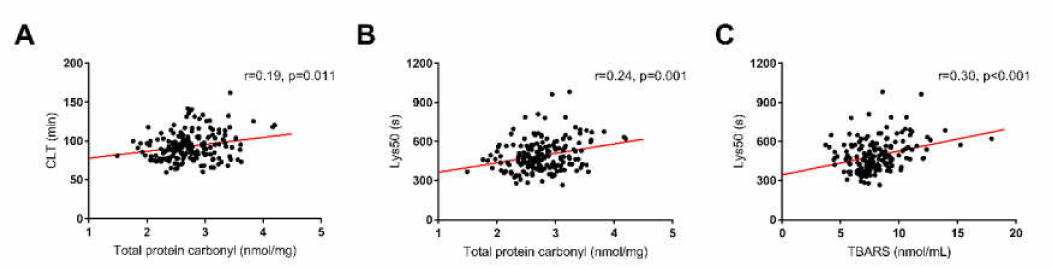
Figure 3. Correlations of oxidative markers levels with fibrinolytic e ffi ciency: ( A ) total protein carbonyl (PC) with clot lysis time (CLT); ( B ) PC with lysis time (Lys50); and ( C ) thiobarbituric acid reactive substances (TBARS) with